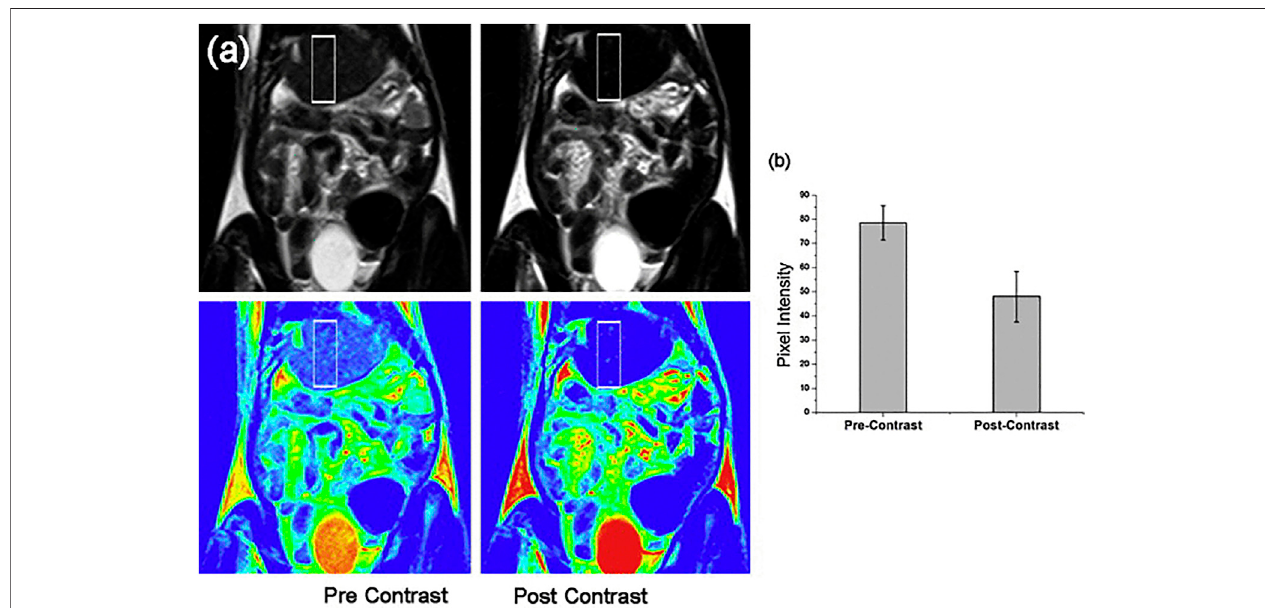
FIGURE 3 | Comparison of pre- and post-contrast in vivo MRI of the liver in a region of interest from fi brosed areas (above) and in colorized images of the original MRI (below) after 10 min of application of citrate-coated ultrasmall SPIONs (A) . The graph of pixel intensity in pre- and post-contrast of liver is presented in (B) . Reproduced with permission (Saraswathy et al., 2014) Copyright 2014, Elsevier